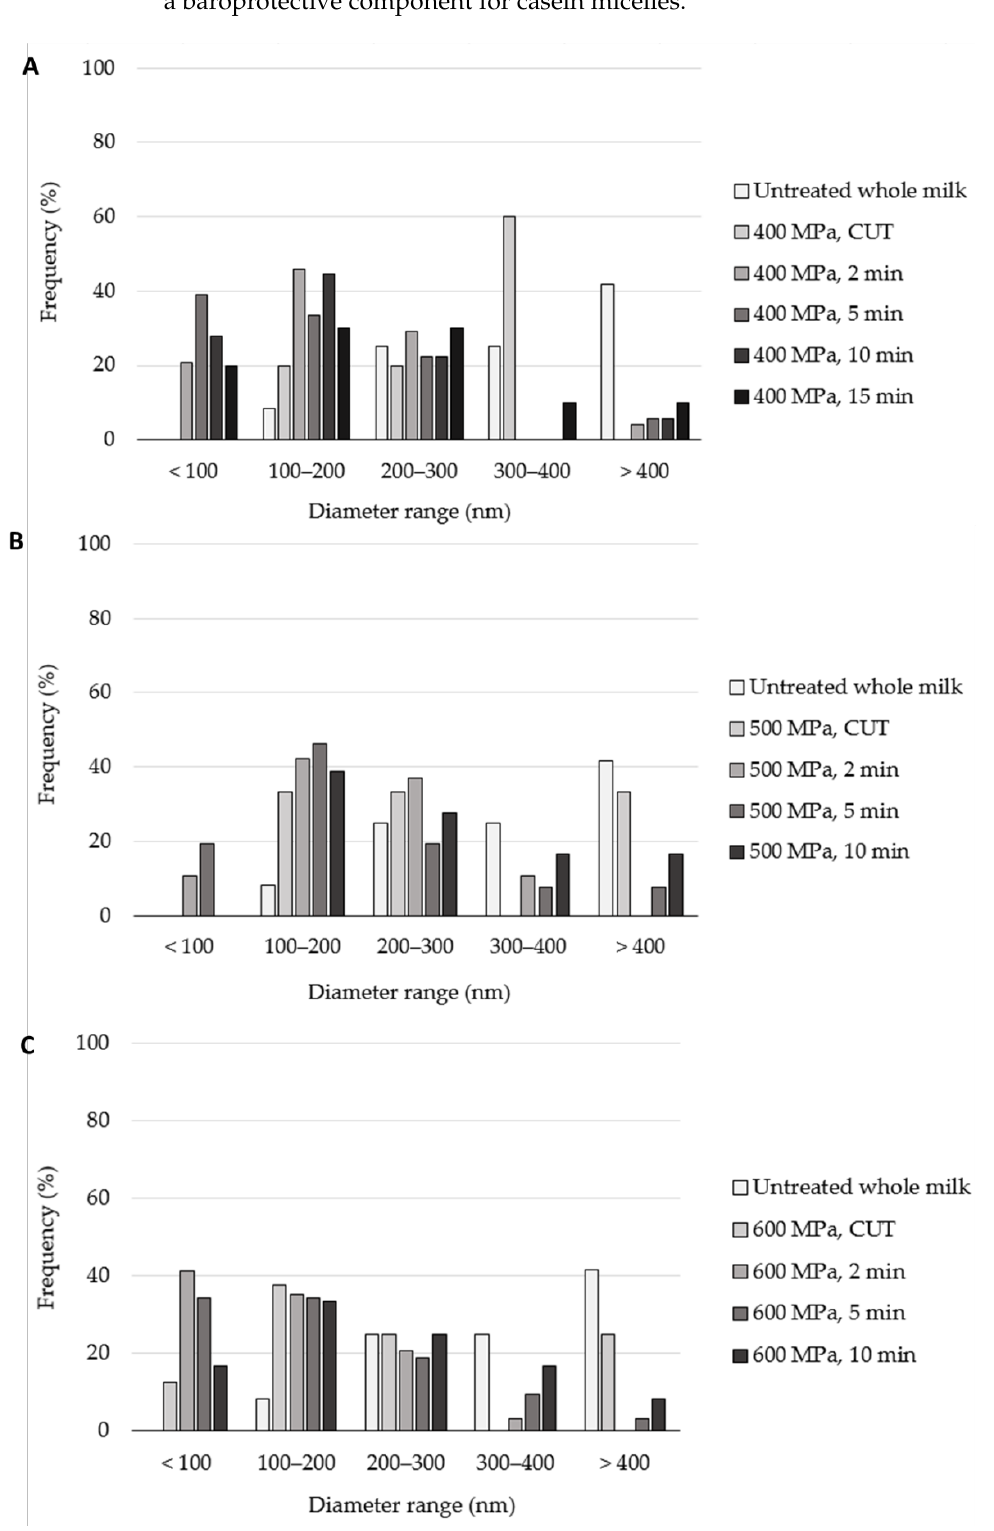
Figure 7. Casein micelle diameter distribution in high-pressure-treated homogenized whole milk samples at 400 ( A ), 500 ( B ) and 600 MPa ( C ). The measurements were recorded from the micrographs by the scanning electron microscopy equipment software.